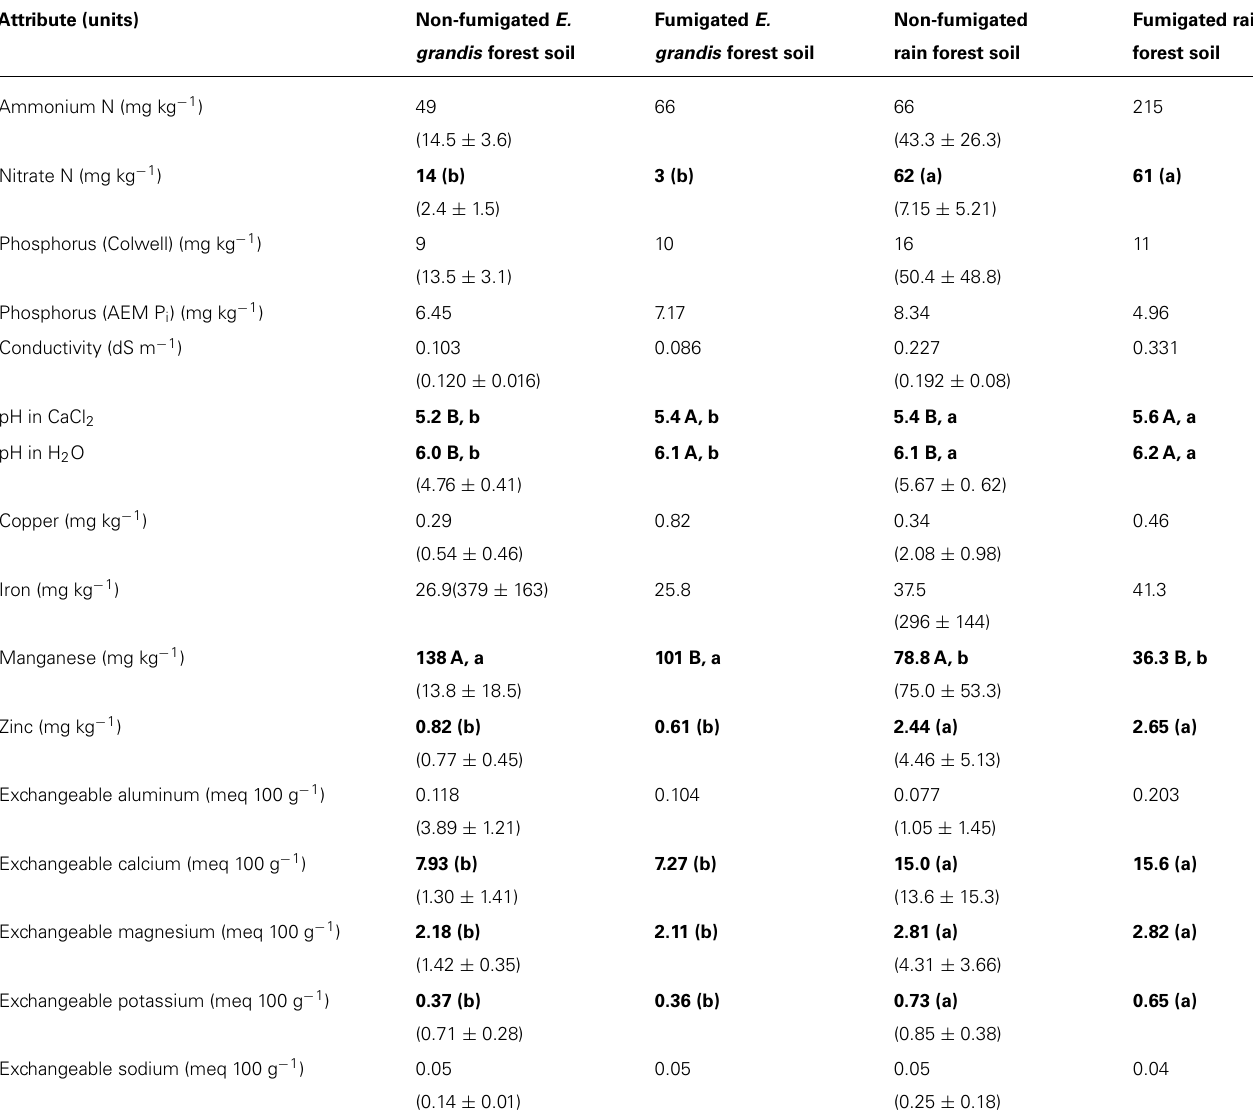
Table 1 |Attributes of non-fumigated and fumigated Eucalyptus grandis forest and adjacent rain forest soil collected from Davies Creek, Far North Queensland (17 1’30 (cid:2)(cid:2) S, 145 ◦ 35’46 (cid:2)(cid:2) E). Attribute